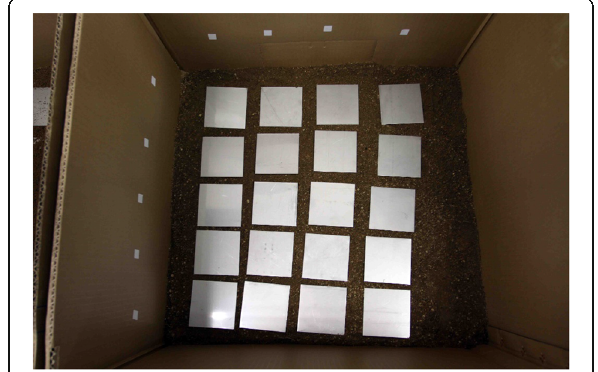
Fig. 2 Metal plates were placed on the first layer of the soil after